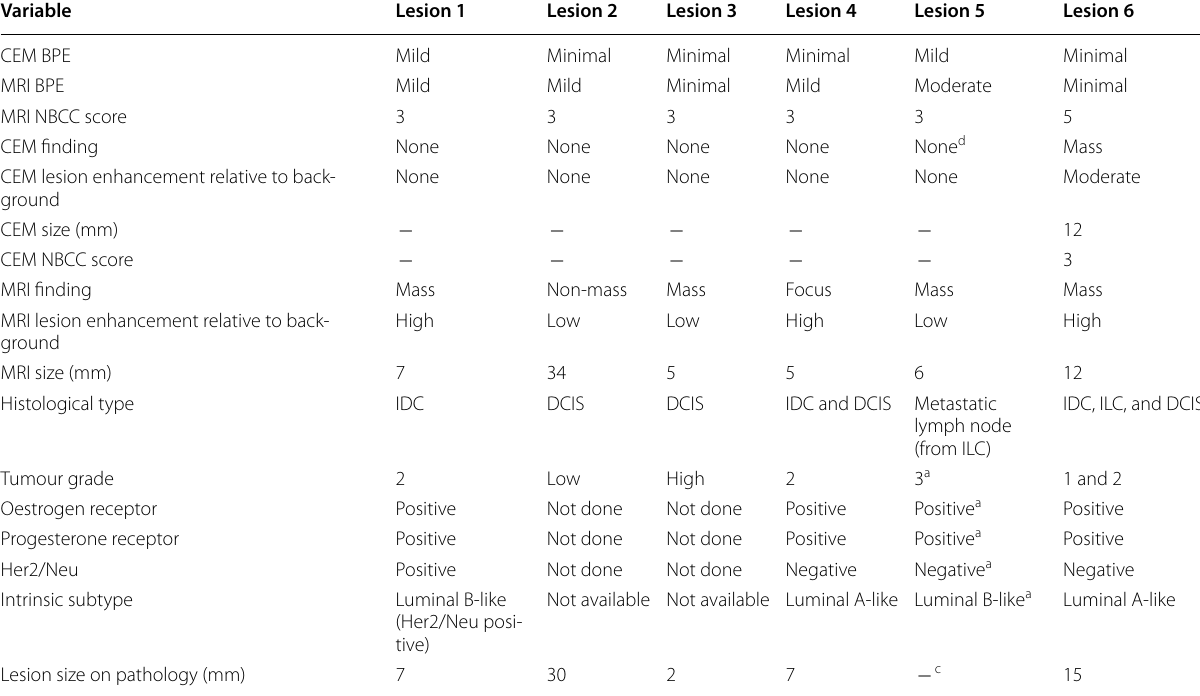
Table 3 Features of the six additional malignant